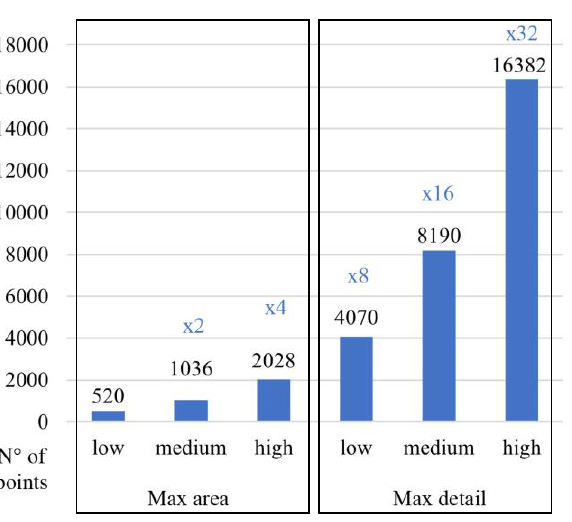
Figure 7 . Exponential increase of the total number of points recorded by the sensor according to the combination of mode (max area, max detail) and quality (low, medium, high).